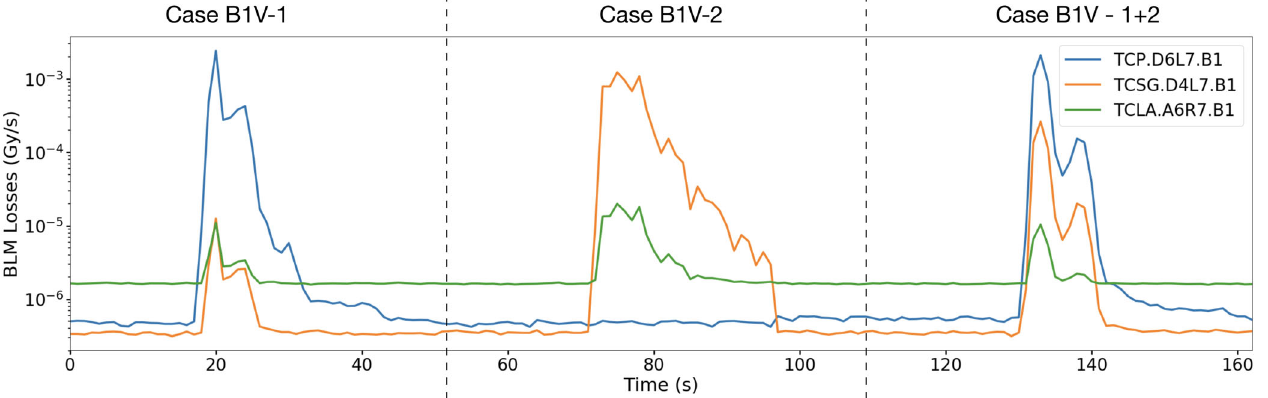
FIG. 4. Series of beam loss signals recorded for a subset of collimators in the vertical plane in beam 1. Case B1V-1 and case B1V-2 involve individually closing TCP.D6L7.B1 and TCSG.D4L7.B1, respectively, while case B1V- 1 þ 2 involves closing both collimators simultaneously, to ultimately predict the cross-talk experienced by the most downstream collimator,